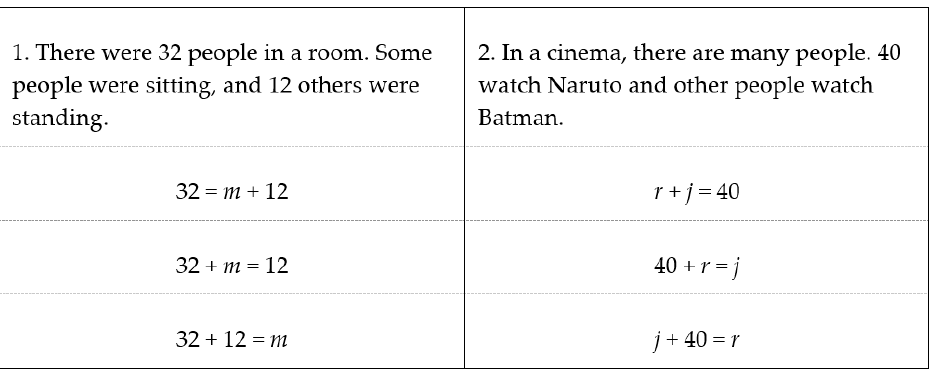
Figure 4. Test part 2.